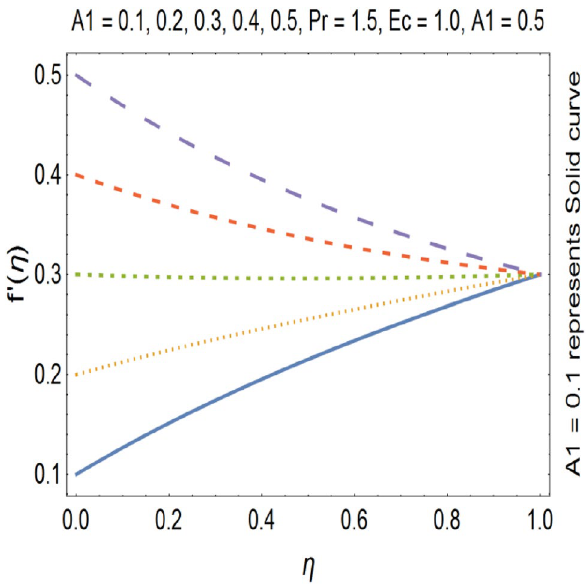
Figure 9. Velocity profile for various A1.